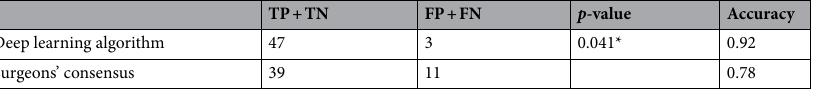
Table 4. Comparison of the diagnostic accuracy between the deep learning algorithm and the consensus of four spine physicians (n = 50). *Chi-square test. TP, true positive; FP, false positive; FN, false negative; TN, true